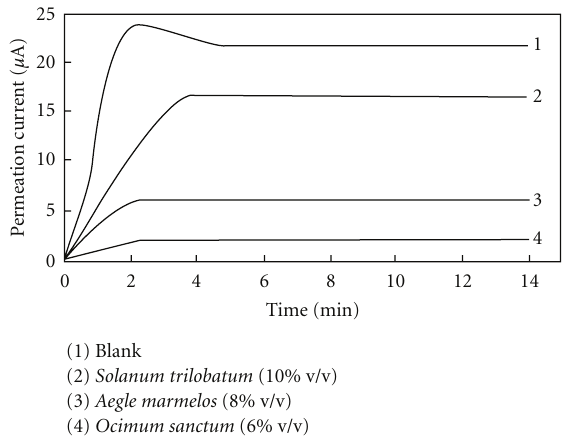
Figure 13: Hydrogen permeation current versus time plots for mild steel in 1N HCl solution in the absence and presence of an optimum concentration of the